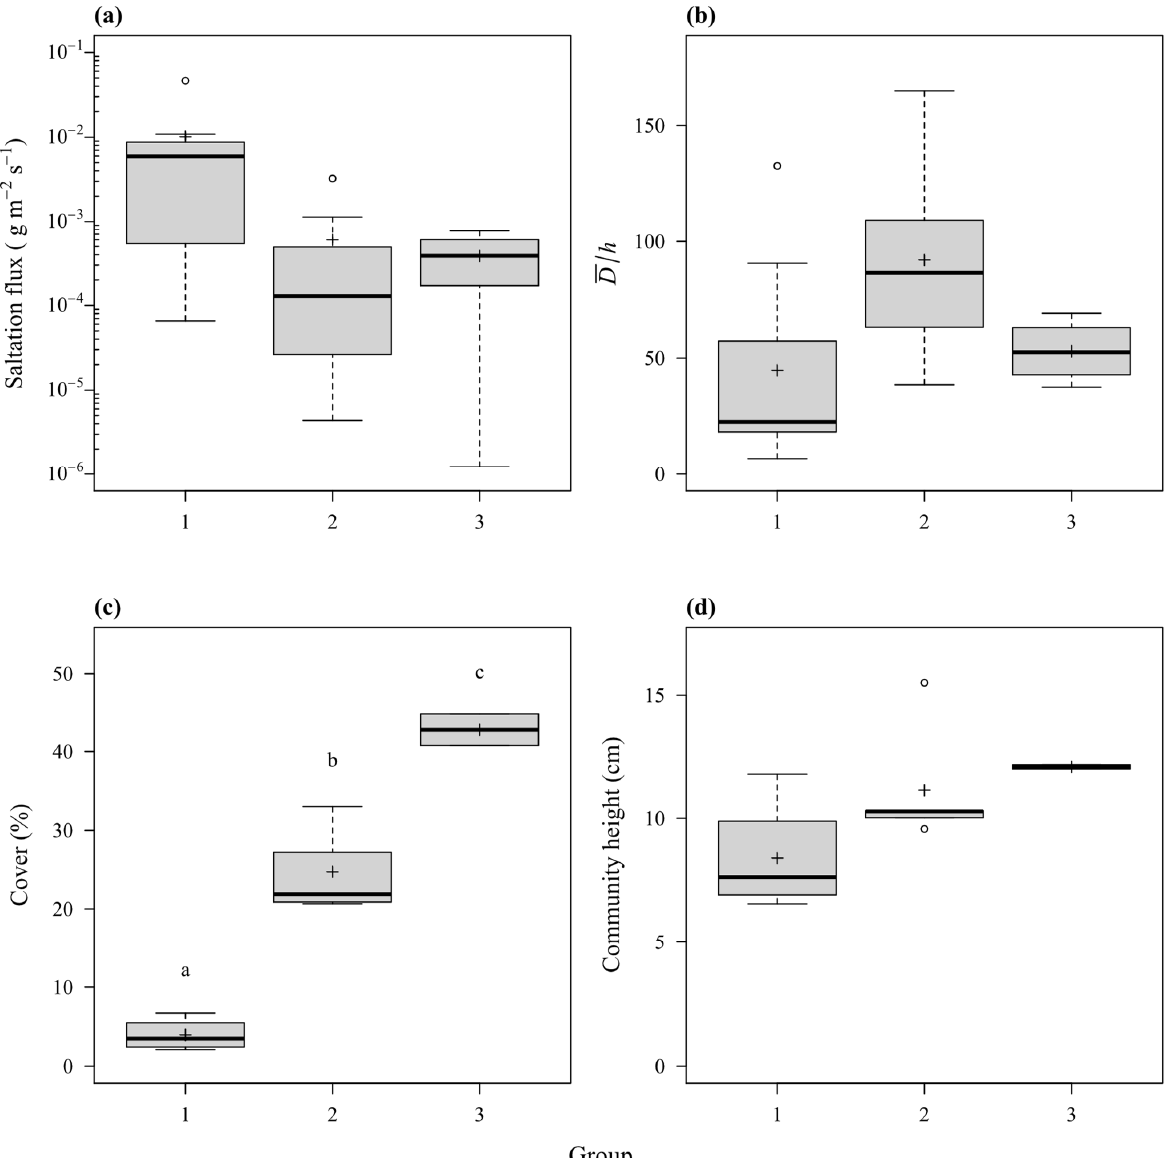
Figure 5. ( a ) Saltation flux; ( b ) intershrub distance D / h ; ( c ) cover, and ( d ) community height h in each group classified by hierarchical clustering. The bold lines within the boxes indicate the median and the + symbols indicate the mean. Different letters in each graph indicate significant differences in between-group comparisons ( 𝑞 values < 0.05).